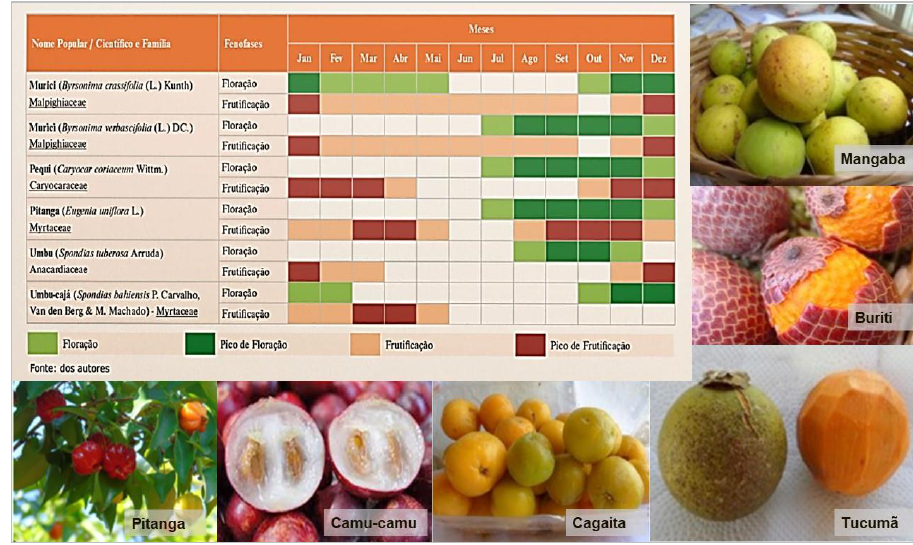
Figure 3. Research into the flowering and fruiting period of wild fruits and greens within a given geography can be used to develop an adaptable tool for informed decision making at both community and government level. Credit: BFN